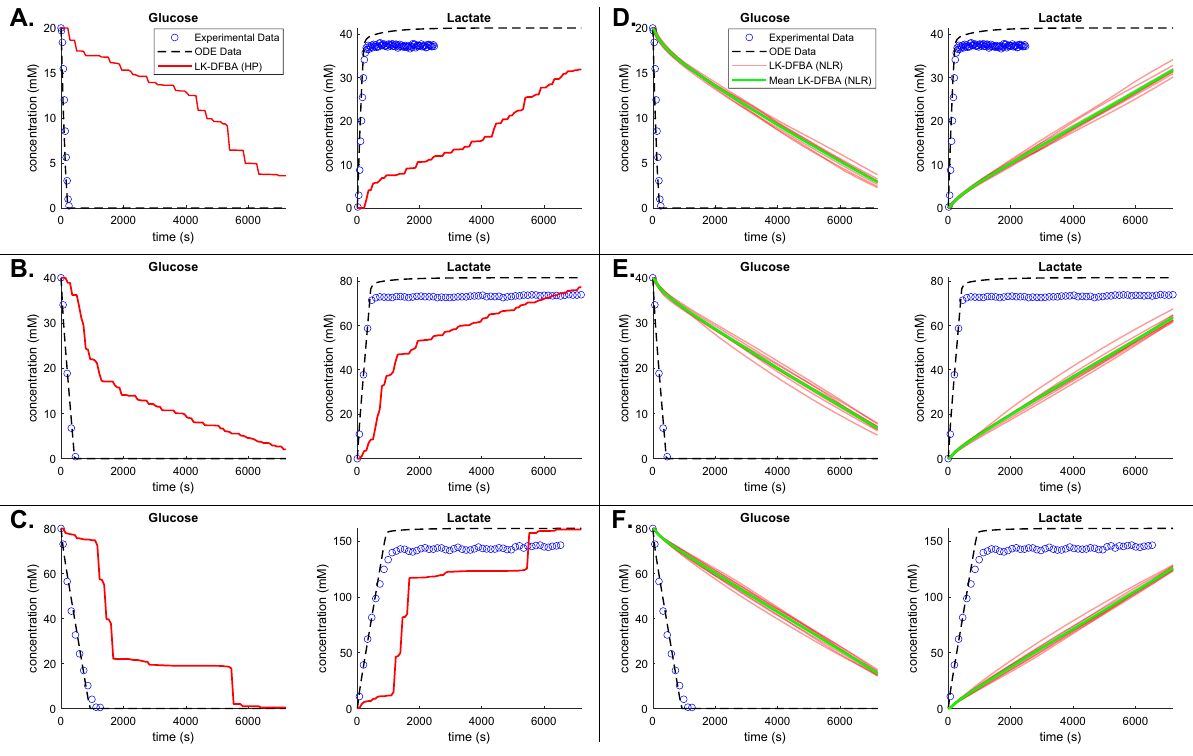
Figure 4. Comparison of LK-DFBA metabolite concentration predictions against ODE data and L. lactis experimental data when fitted to noiseless and noisy ODE data. Panels A, B, and C depict concentration profiles for LK-DFBA (HP) (solid red line) and the ODE model (dashed black line) compared to experimental data (blue circles) for initial glucose concentrations of 20 mM, 40 mM, and 80 mM, respectively, when LK-DFBA is fitted to noiseless data. Panels D, E, and F depict concentration profiles for LK-DFBA (NLR) on 10 noisy datasets (nT = 15, CoV = 0.15) and the ODE model compared to experimental data. The mean concentration profile (solid green line) is shown with each of the concentration profiles (solid red lines) from the 10 noisy